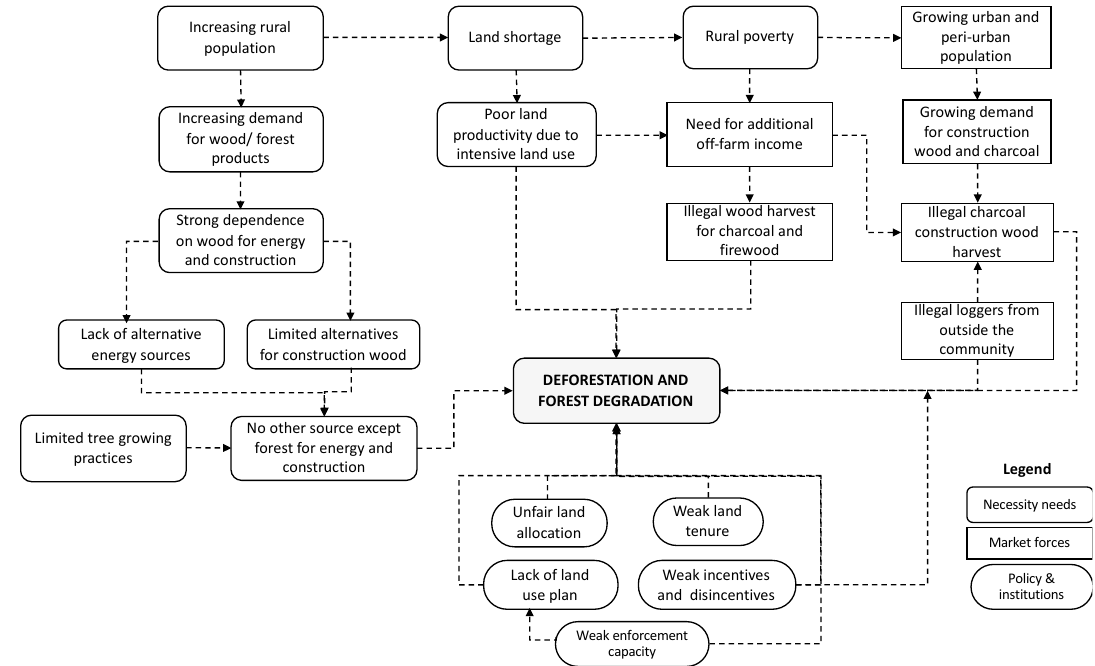
Figure 4. A schematic of processes leading to smallholder-driven D&D at a local level. Note the crosscutting nature of the policies and governance issues.